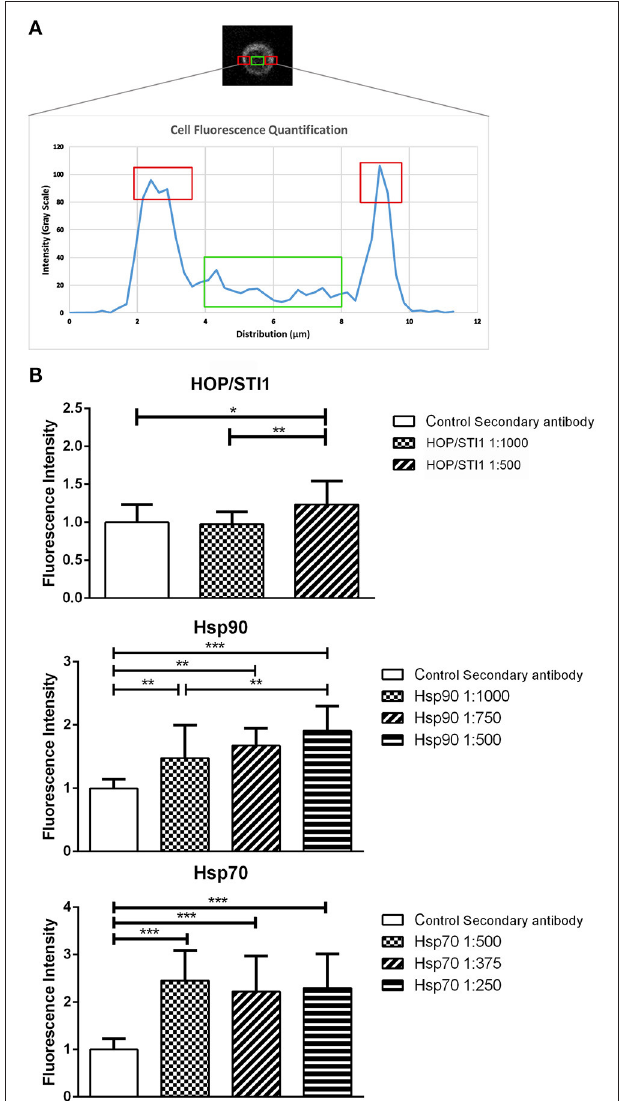
FIGURE 5 | Proteins from a chaperone heterocomplex are present in the cell membrane. Live labeling of primary SVZ cultures detects antibody binding to cell membranes (A) plot that exemplifies how fluorescence analysis was performed in order to evaluate protein localization in single SVZ cells. Red areas correspond to the peak intensity signal detected from the cell membranes, while the green area depicts basal fluorescence level around the nucleus. (B) Quantification of fluorescence from primary SVZ cultures submitted to live labeling assays. Antibodies that bind to HOP/STI1, Hsp90 and Hsp70 generate fluorescence signal that is significant higher than all negative control groups and it is also dose dependent. One way Anova, Tukey multiple comparison test as post-hoc . * p < 0.05, ** p < 0.01, *** p < 0.001.